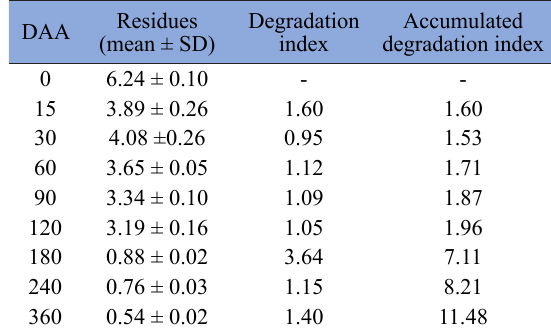
Table 1. Fenitrothion residues (mg kg −1 ) in wheat grains treated with the insecticide mixture fenitrothion + esfenvalerate.